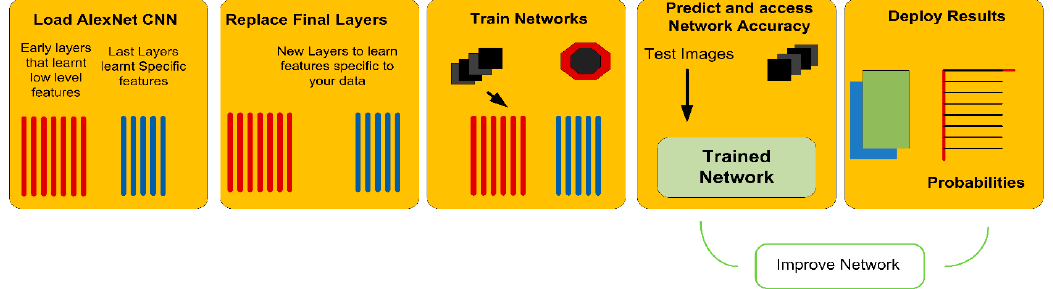
Figure 6. Transfer learning of AlexNet CNN network.